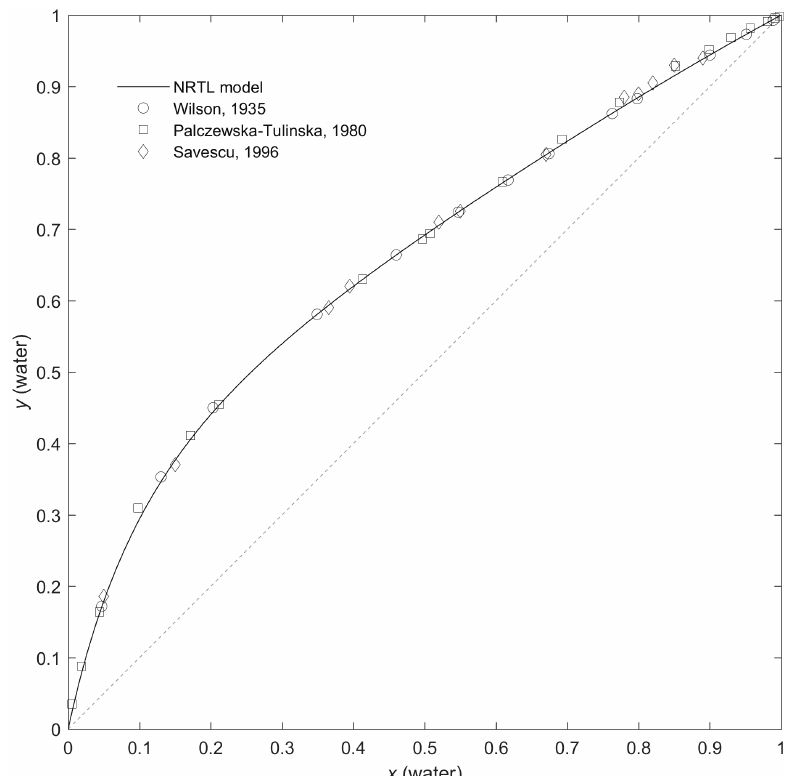
Fig. 3 – VLE data and NRTL model for the morpholine–water system